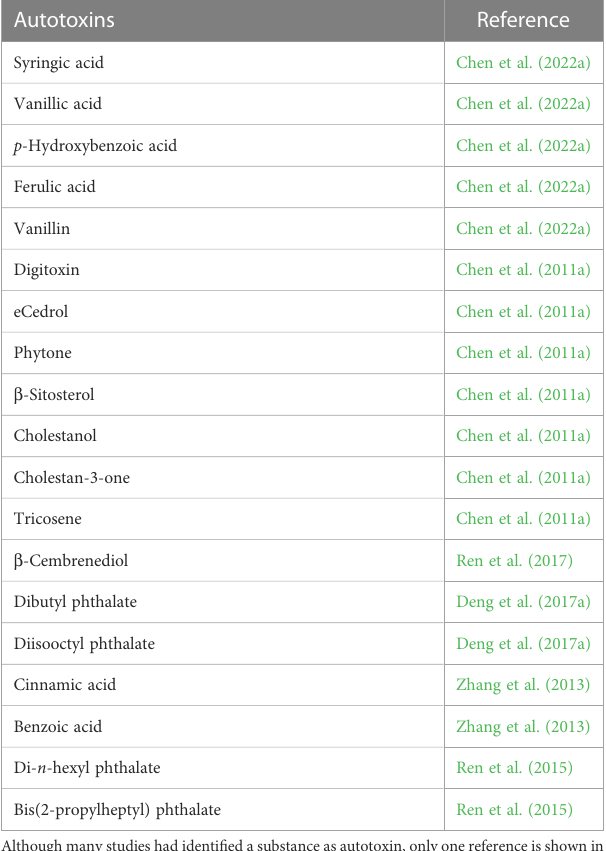
TABLE 1 Autotoxins in tobacco continuous cropping soil